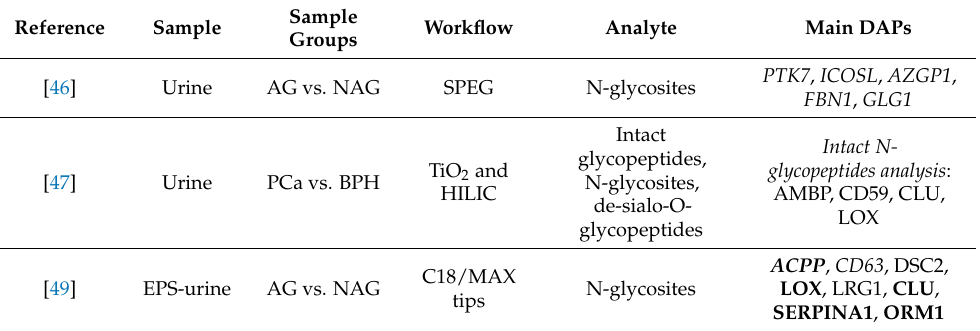
Table 3. Main differentially abundant glycoproteins (DAPs) identified in PCa urine samples by MS-based workflows. Plain text = discovery level; bold character = validation level; italic = protein is